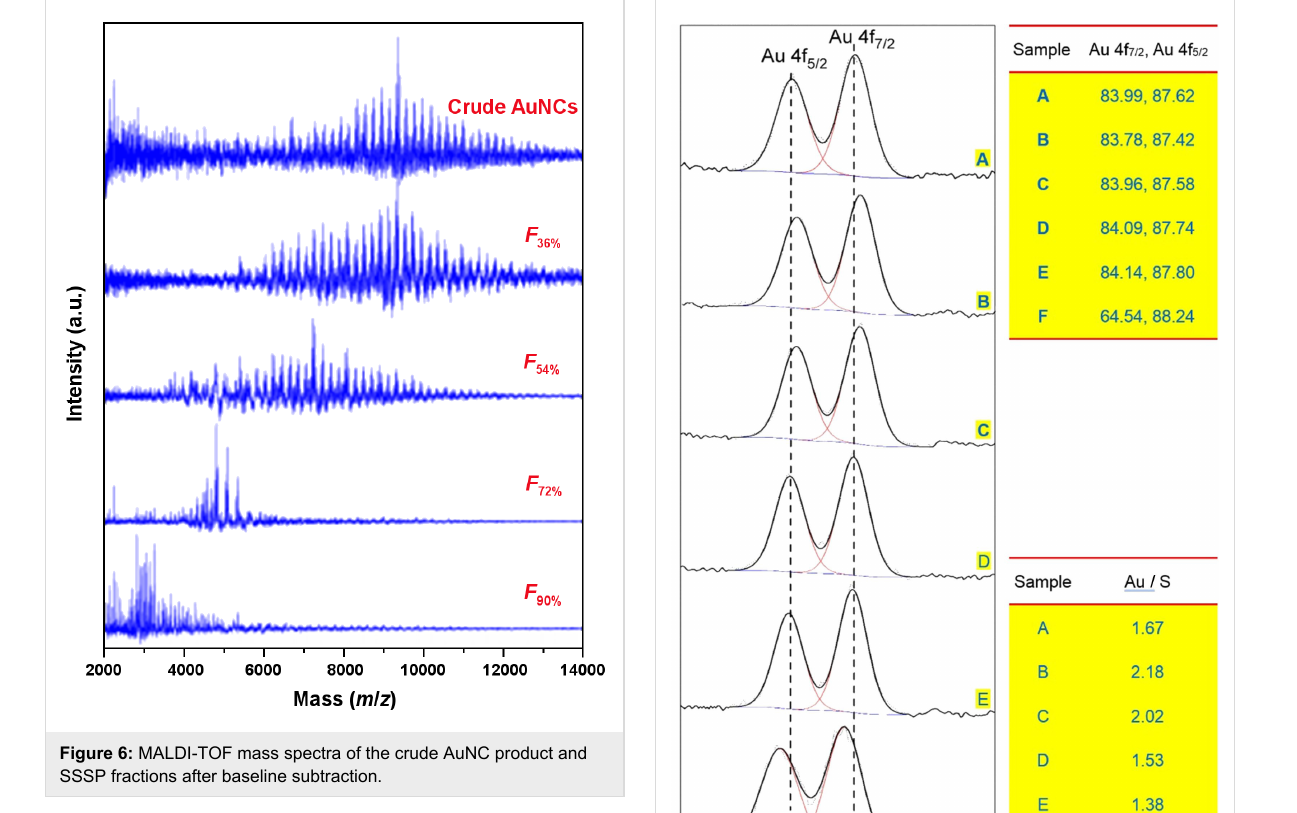
ysis of the crude AuNC product and the SSSP fractions using